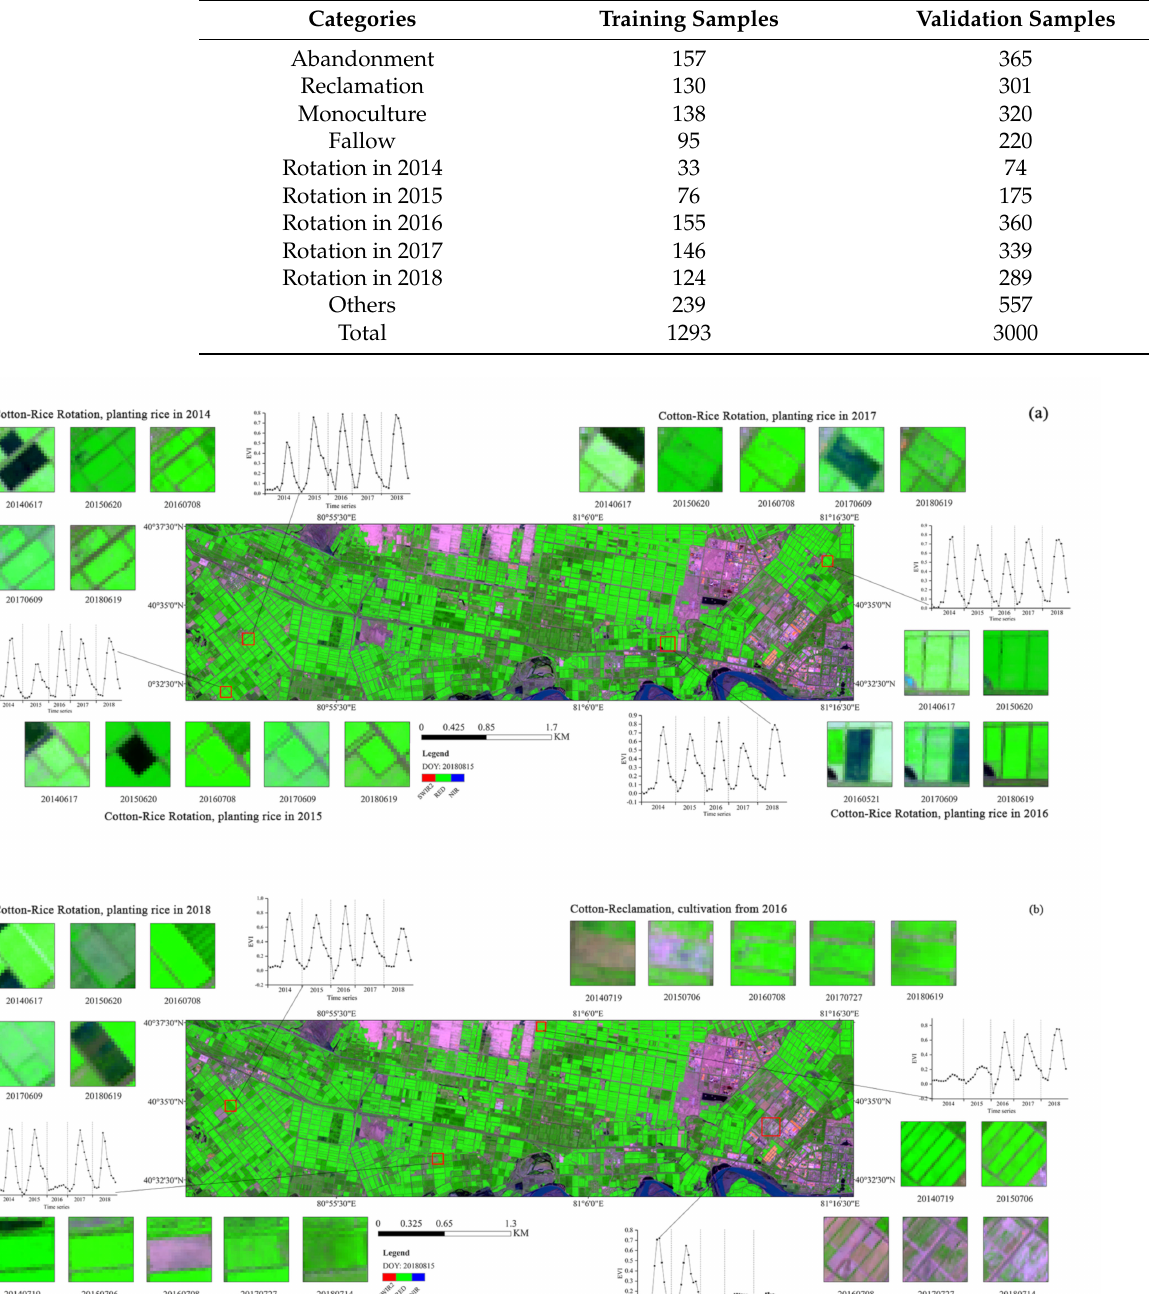
Table 2. Training and validation samples for multi-year cotton-cropping patterns.